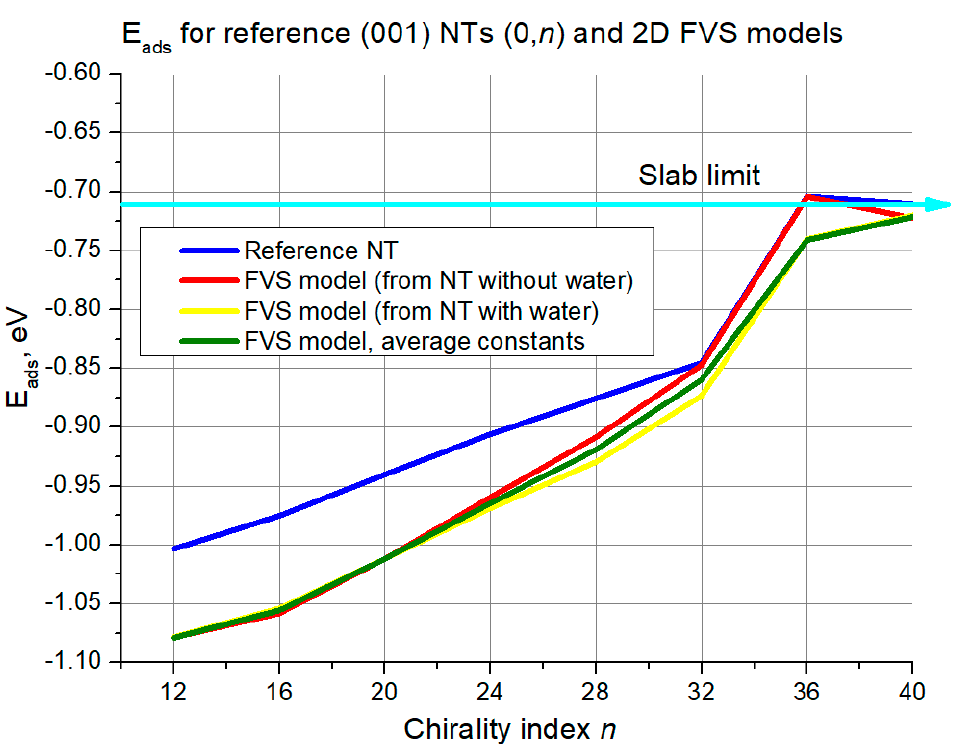
Figure 13. Adsorption energies for (001) NTs (0, n ) and their 2D FVS models. The cyan line with the arrow denotes the slab limit for water adsorption energy.